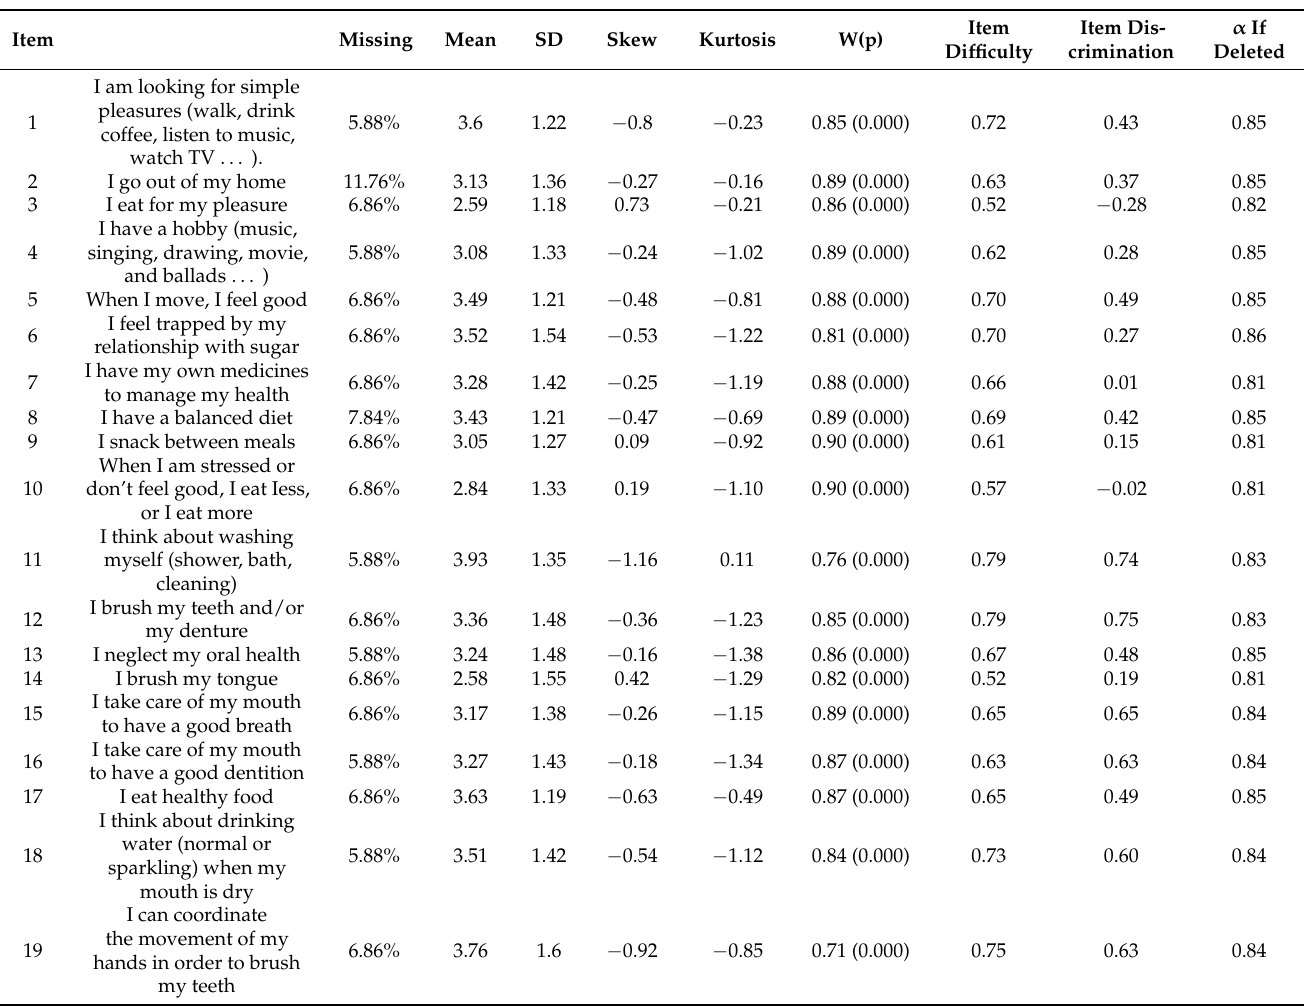
Table 2. Rasch analysis for SCOOHP (23